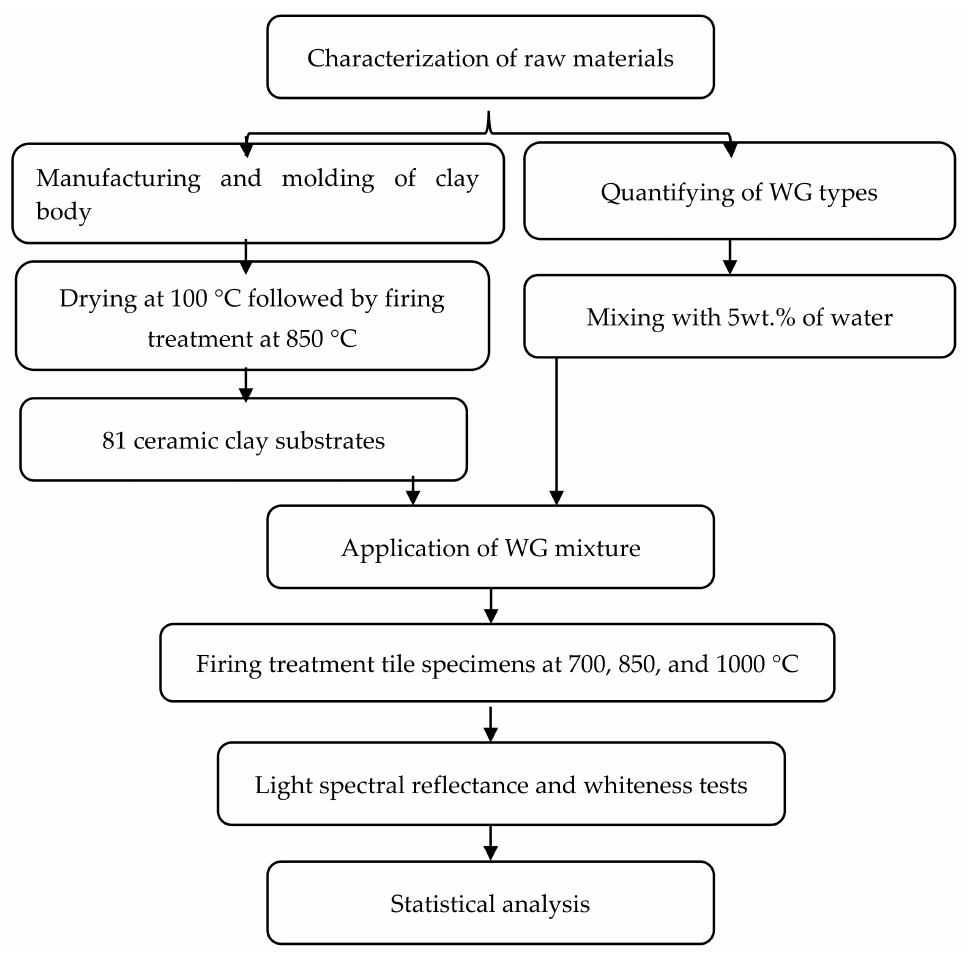
Figure 1. Flowchart of the research